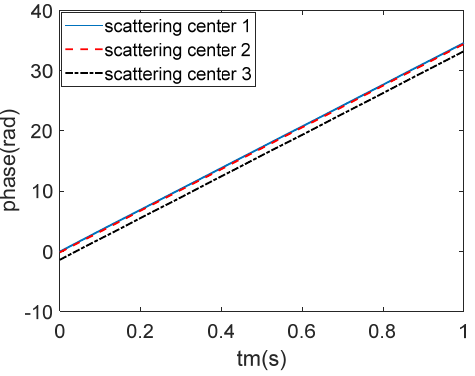
Figure 7. Phase difference curves after phase unwrapping based on the SSCF technique.